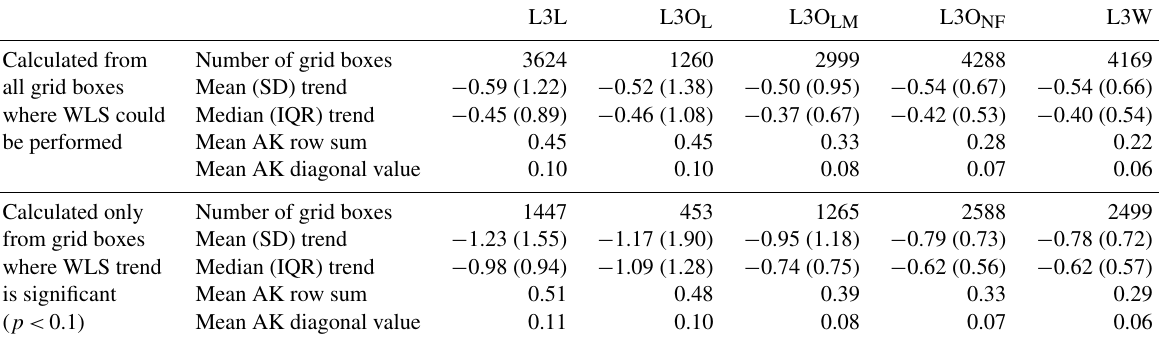
Table 5. Descriptive stats corresponding to the WLS trends detected in L3L, L3W, and selected L3O subsets. Also shown are mean averaging- kernel row sums and diagonal values corresponding to the retrievals from which trends are calculated. SD denotes standard deviation; IQR denotes interquartile